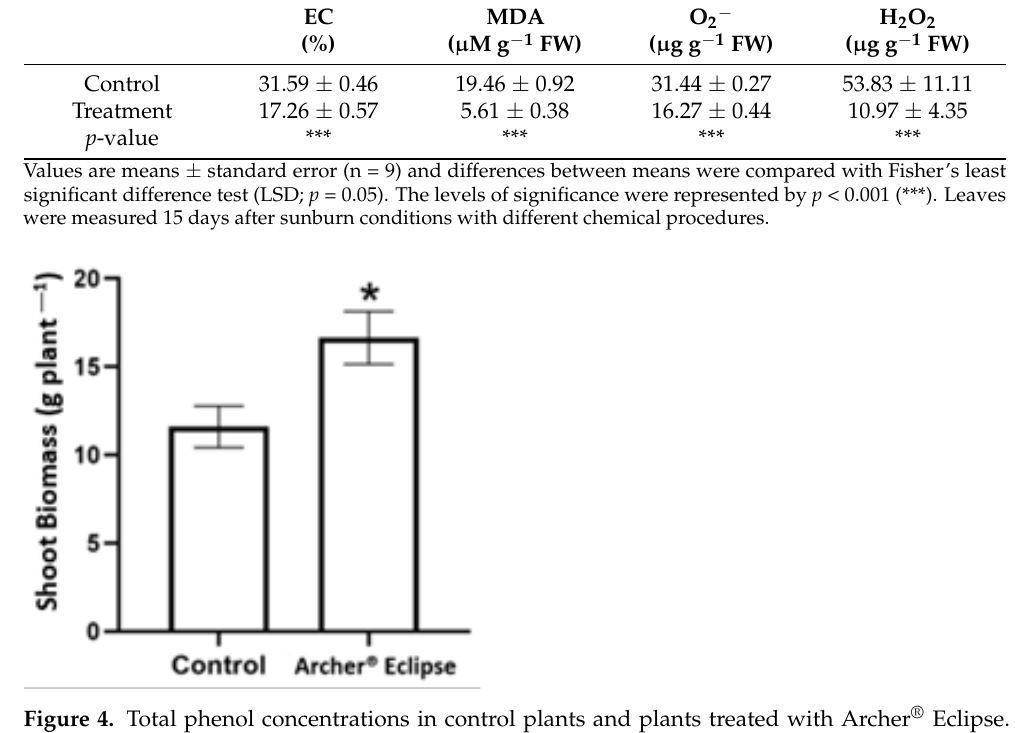
Figure 4. Total phenol concentrations in control plants and plants treated with Archer ® Eclipse. Values are means ± standard error (n = 9) and differences between means were compared with Fisher’s least significant difference test (LSD; p = 0.05). The levels of significance were represented by p < 0.001 (***).